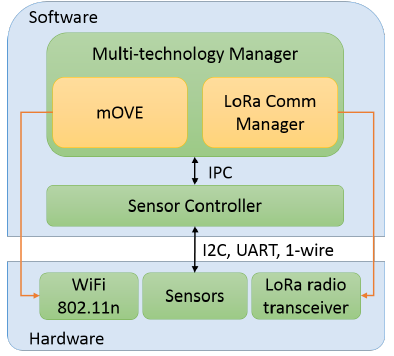
Figure 3. Mobile node software architecture. mOVE: mobile Opportunistic VEhicular.